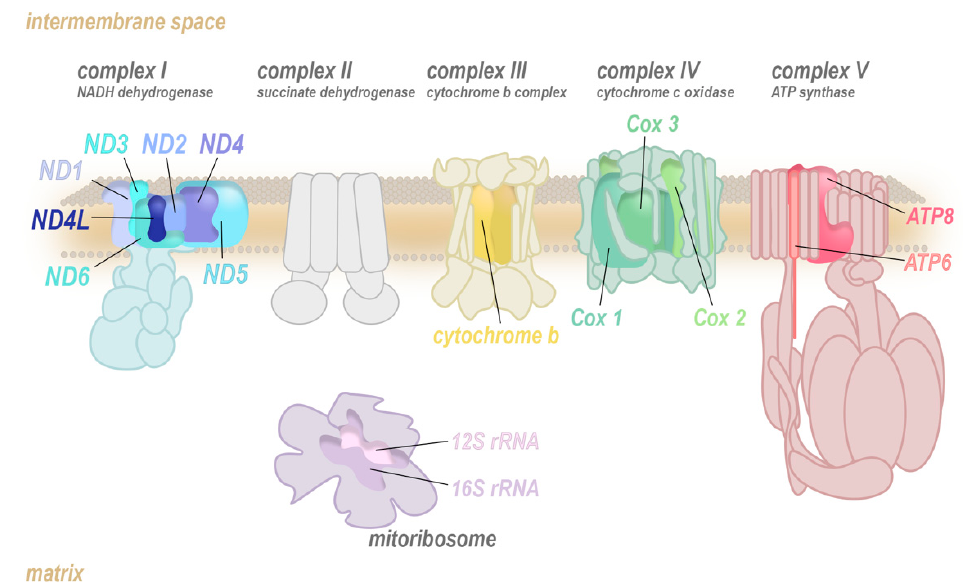
Figure 1. Subunit composition of each mitochondrial respiratory complex.